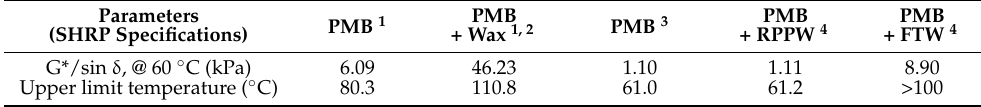
Table 6. Effects of three different waxes on the rutting resistance parameters of two